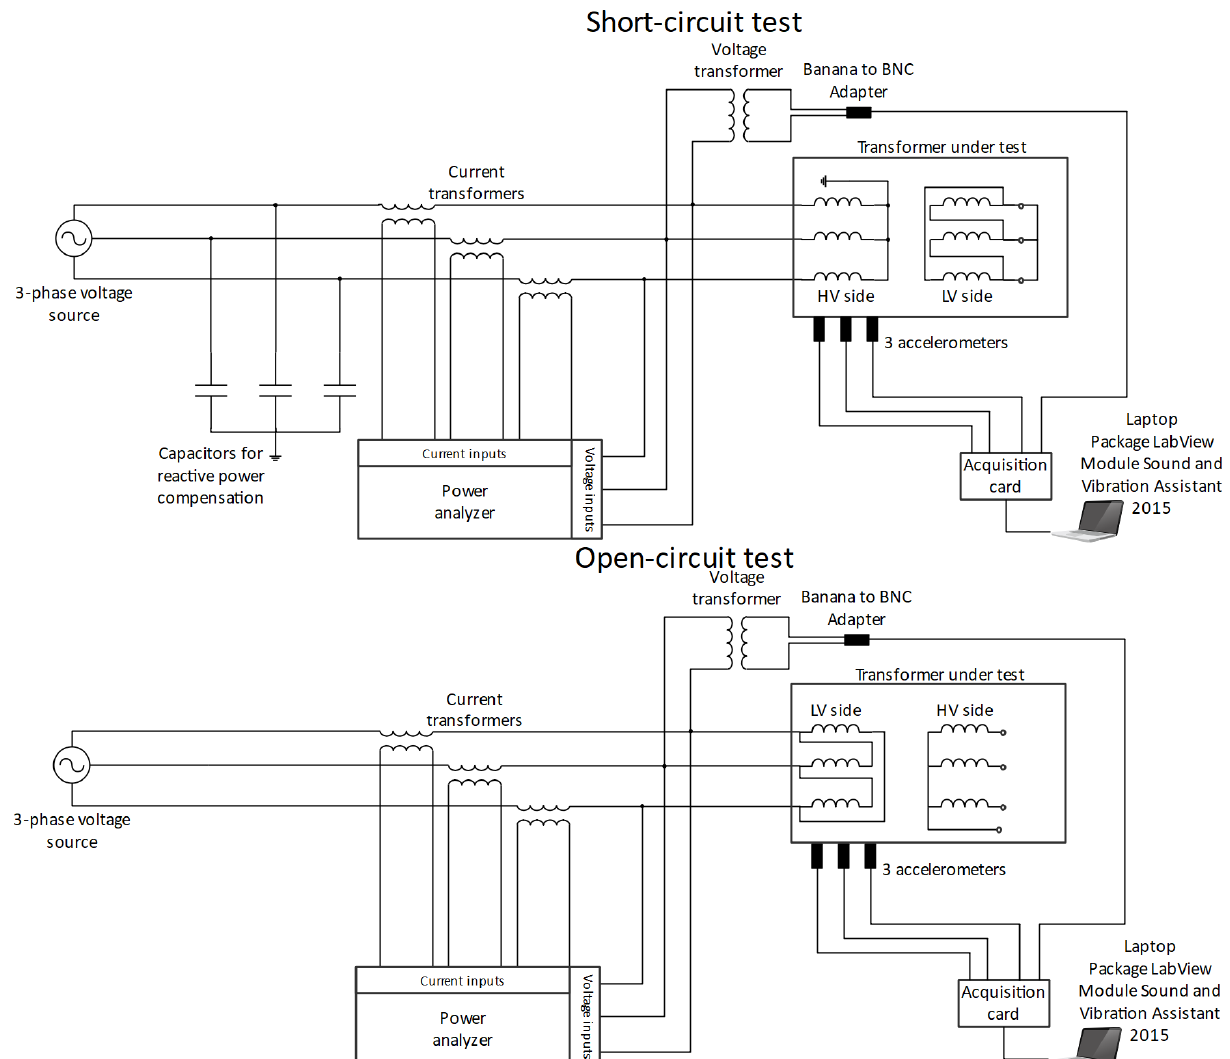
Figure 1. Electrical and vibration measurement setup diagram in open-circuit and short-circuit tests. Vibrations are measured on the surfaces of the tank wall, stiffeners, and cover of the 5 MVA transformer experimental model. The measurements on the transformer tank